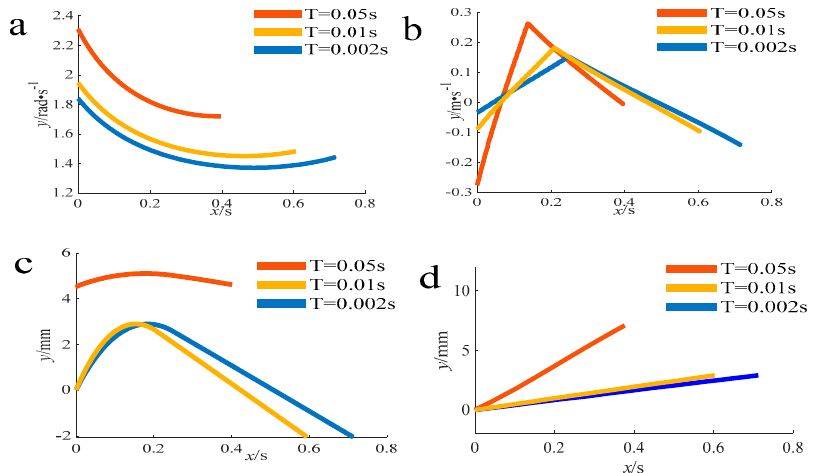
Figure 10. Simulation results of transplanting trajectory. ( a ) Angular velocity of rotating motor, ( b ) speed of sliding table, ( c ) horizontal trajectory deviation, and ( d ) vertical trajectory deviation.